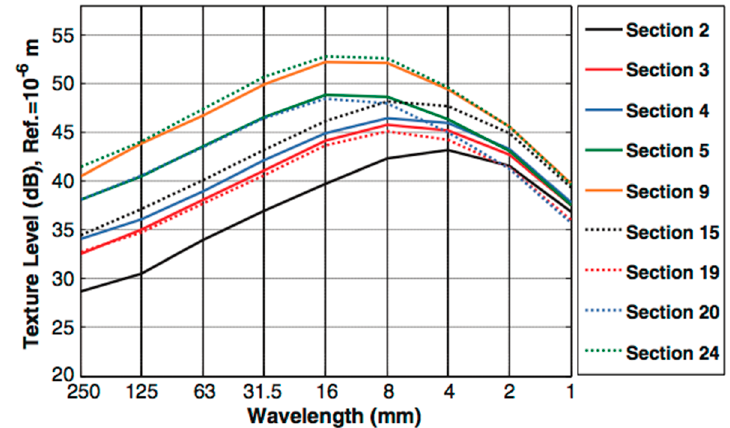
Figure 24. Surface texture levels for the thin-layer surfacing sections (source from Li et al., 2015 [193], Figure 3; reprinted with permission from American Society of Civil Engineers).